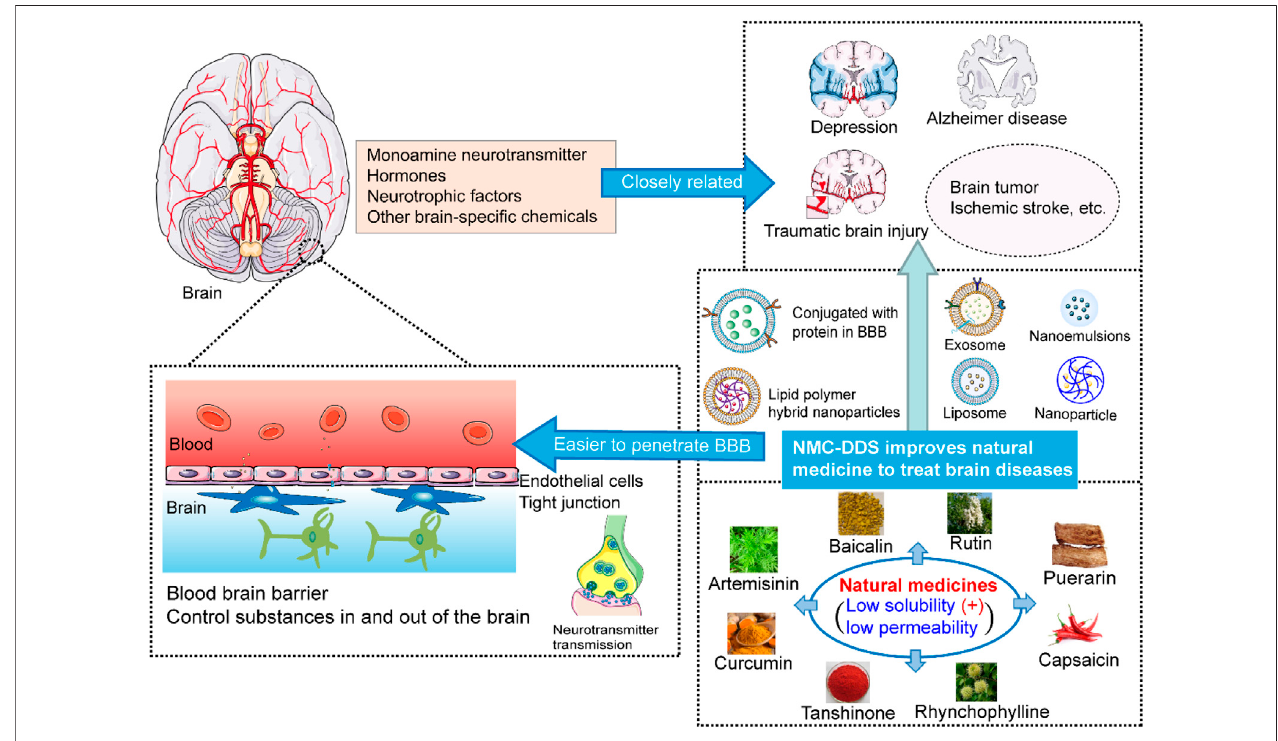
FIGURE 1 | The schematic diagram for natural medicine delivery systems to improve bioactivity, increase metabolism and pharmacokinetic characteristics.